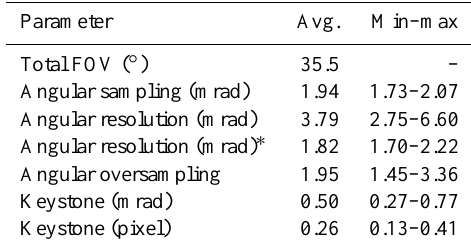
Table 5. Summary of the geometric across-track properties of the specMACS SWIR sensor excluding the first 17